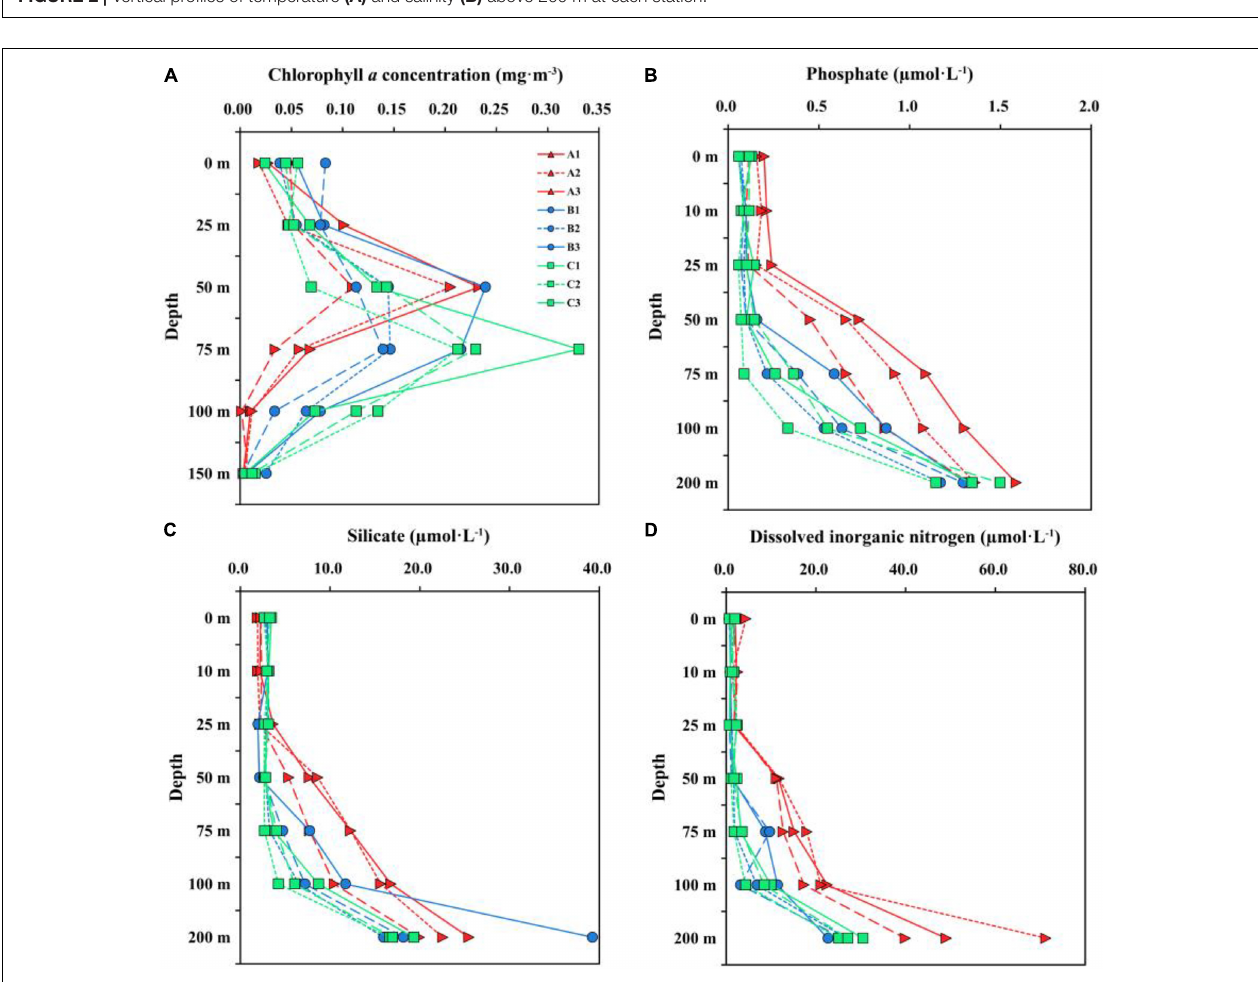
Frontiers in Marine Science |